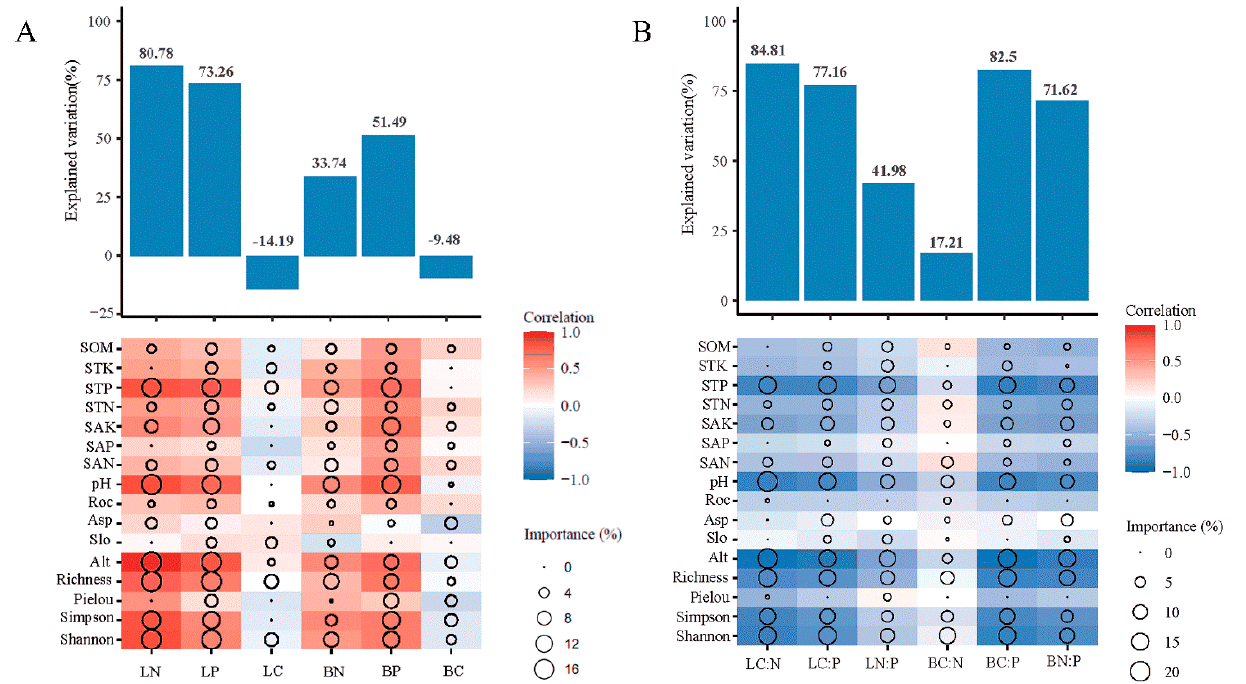
Figure 5. Influencing factors of leaf and branch stoichiometry was analyzed using a random forest model. The dependent variables are the concentrations ( A ) and ratios ( B ) of C, N, and P. The bar graph shows the explained variation for each factor. Circles indicate the importance of independent